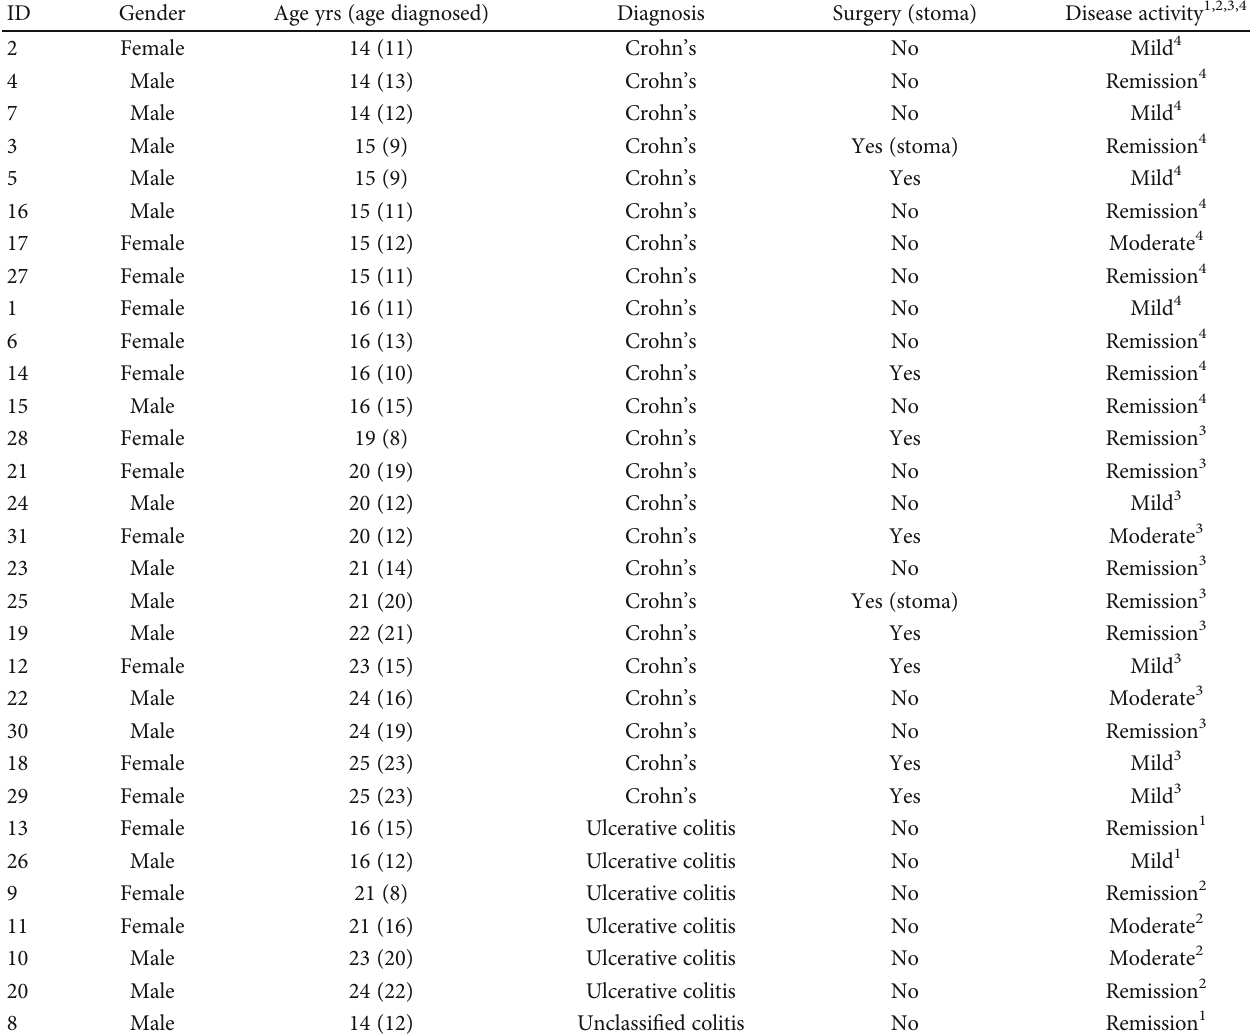
Table 2: Key demographics of